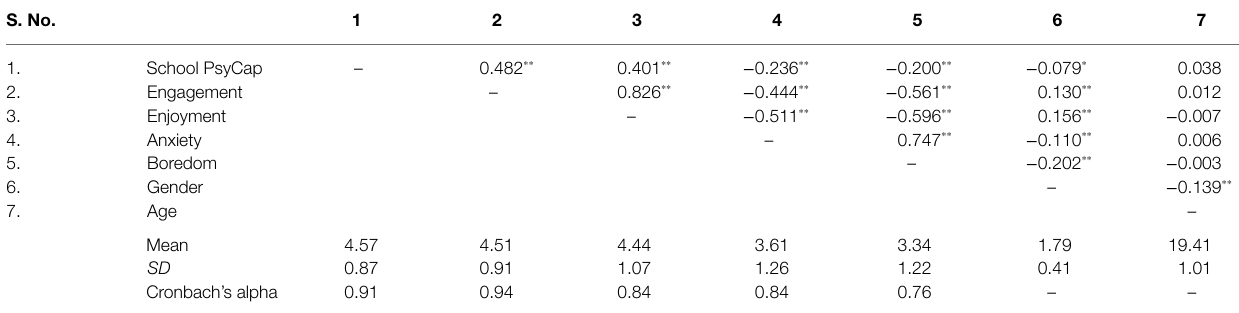
TABLE 4 | Results of descriptive, bivariate correlations, and Cronbach’s alpha reliability. S.